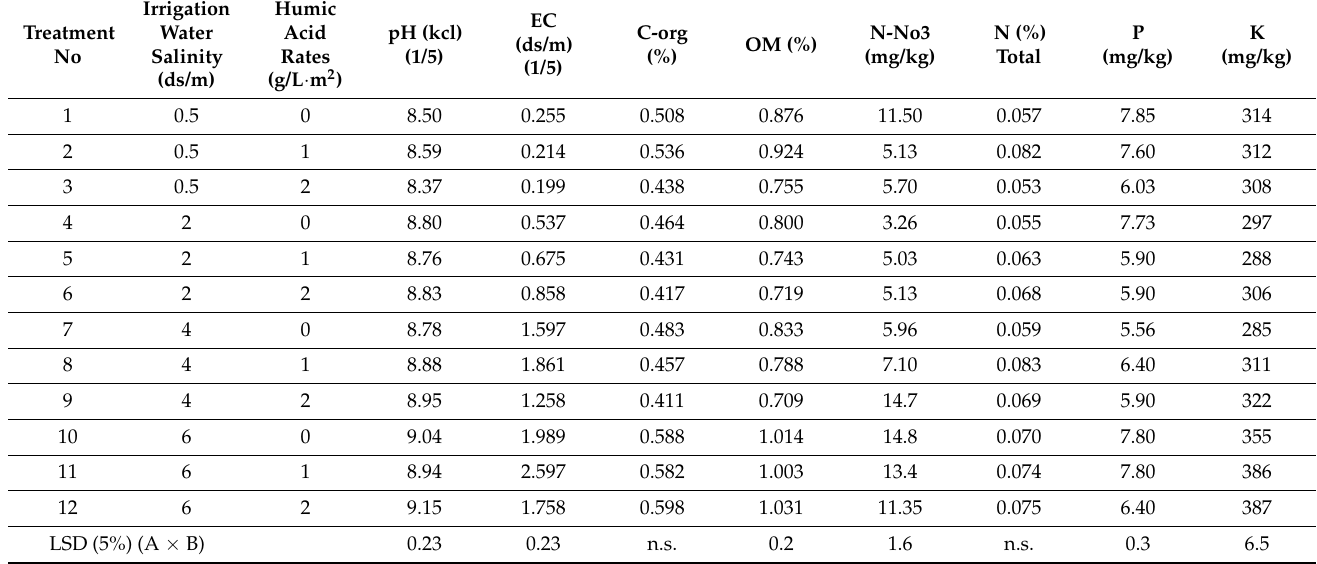
Table 2. Soil chemical properties as affected by the application of different rates of humic acid and irrigation water